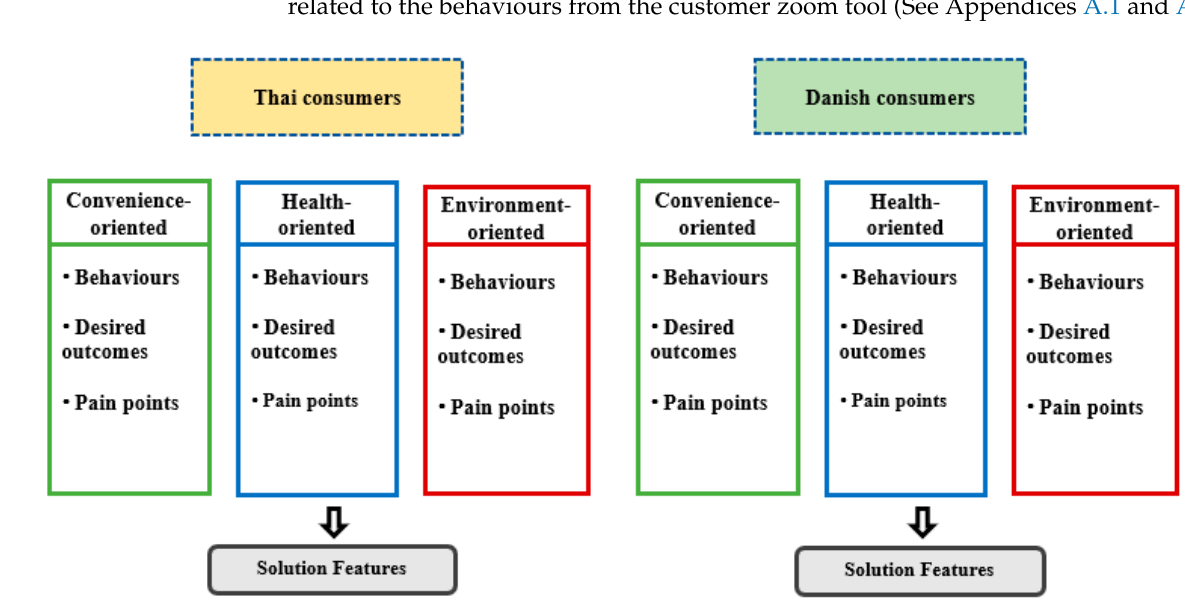
Figure 2. Research Framework. Source. Figure created by authors (2022). Table 1. Segmentation matrix used to classify consumers into the three groups (convenience-oriented, health-oriented, and